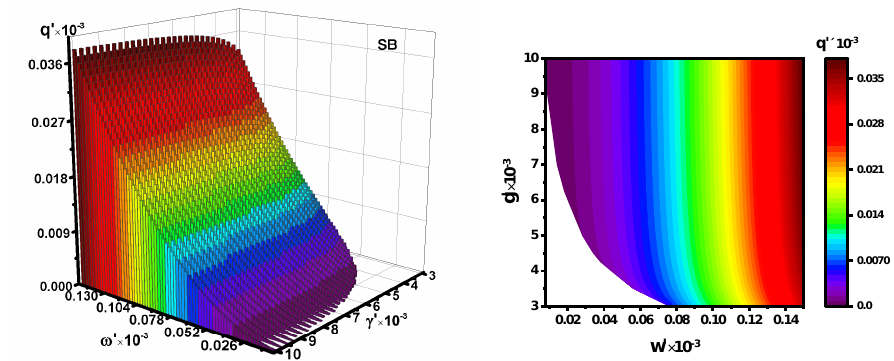
Figure 6. 3D bar and ( γ (cid:48) , ω (cid:48) ) contour plots of TM SB SPs.